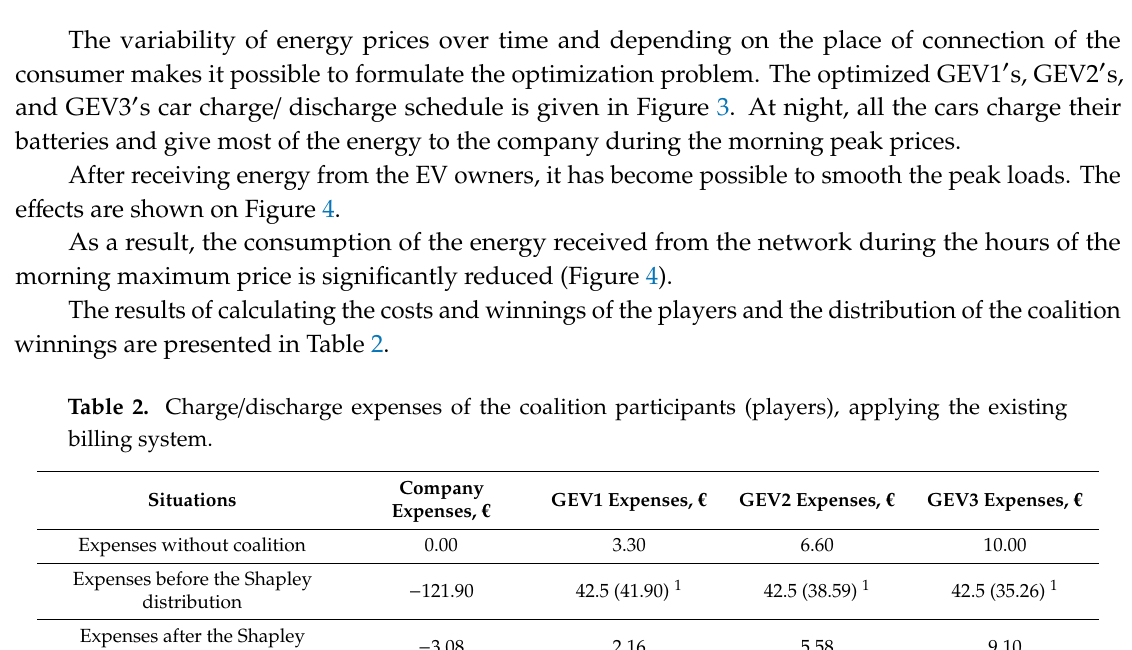
Figure 4. The company’s energy consumption and its price, for one day (6 January 2018), applying the existing billing system.